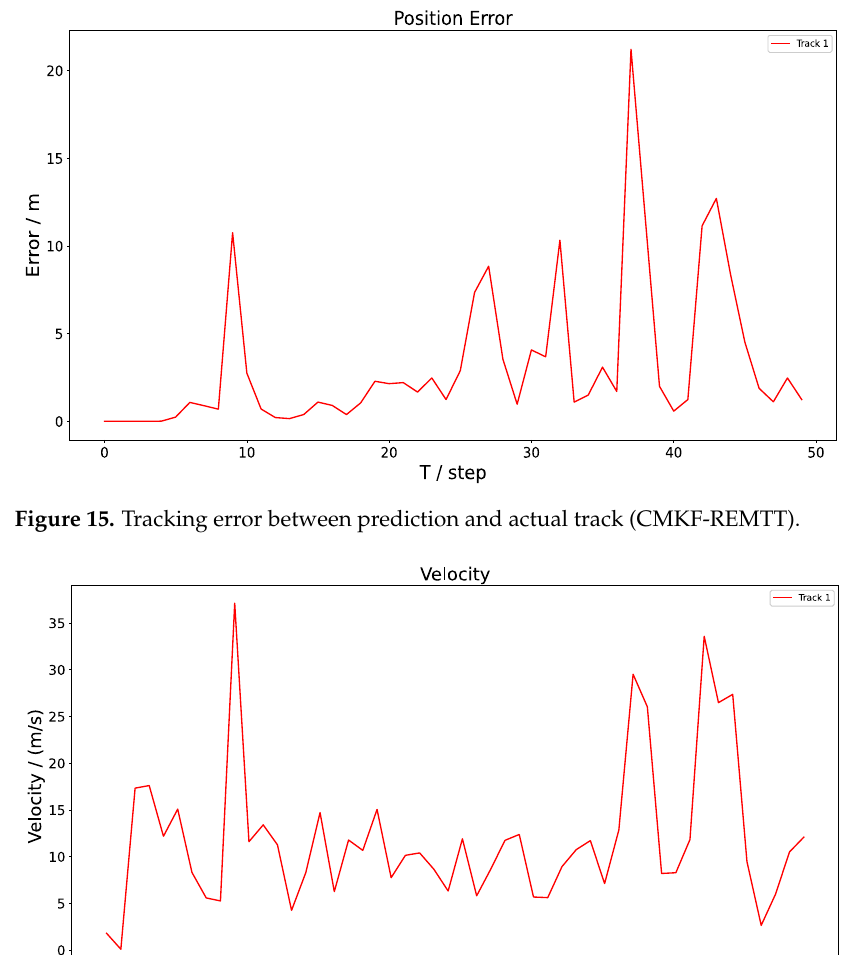
Figure 14. Tracking error between the prediction and actual track (REMTT).